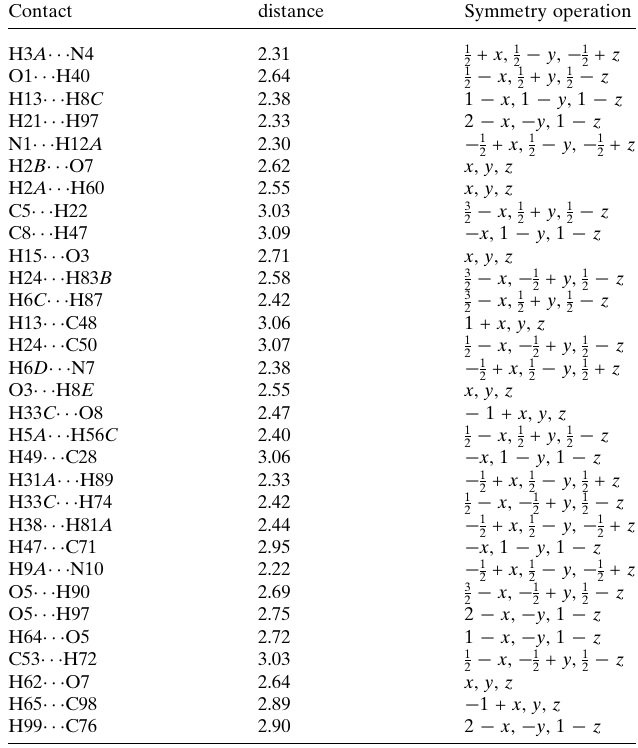
Table 4 Summary of short interatomic contacts (A˚ ) in the title compound. Contact distance Symmetry operation